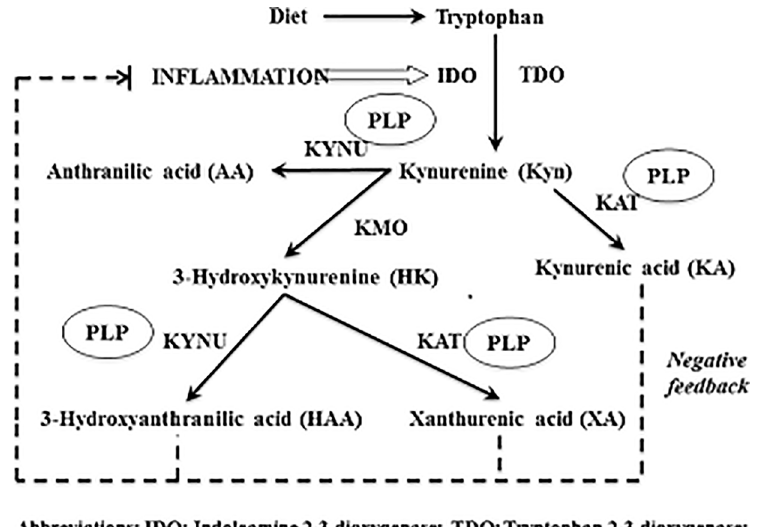
Fig 1. The schematic metabolic pathway of tryptophan and